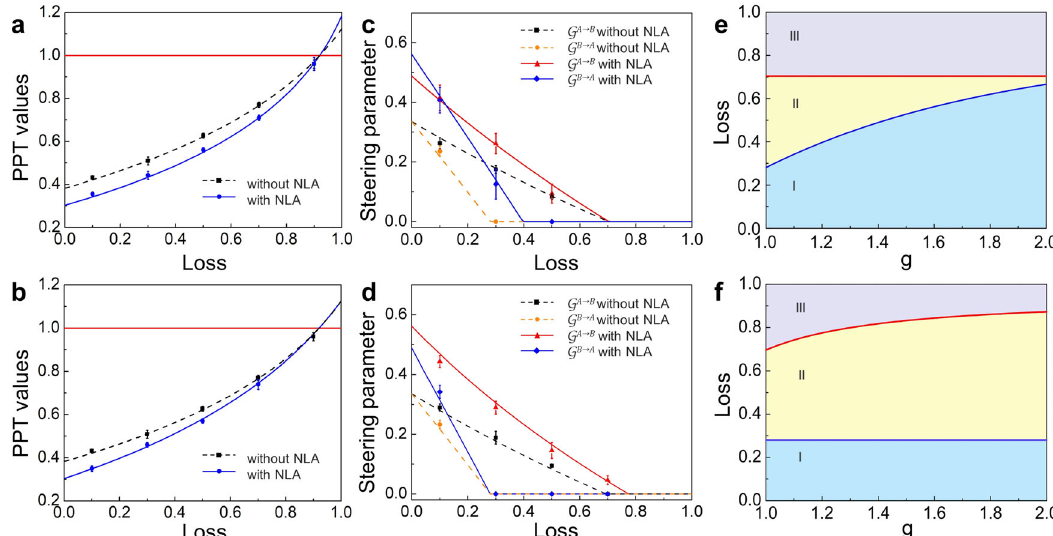
Fig. 3 Results for the distillation in a noisy channel in which the excess noise is taken as 0.12 times of vacuum noise. The PPT values with and without the NLA based on Bob ’ s a and Alice ’ s b measurement results, respectively. Gaussian EPR steering with and without the NLA based on Bob ’ s c and Alice ’ s d measurement results, respectively. The EPR-steerable regions parameterized by loss and gain with the NLA based on Bob ’ s e and Alice ’ s f measurement results, respectively. The blue, yellow, and gray regions are the two-way steerable region (I), one-way steerable region (II), and nonsteerable region (III), respectively. Error bars correspond to one standard deviation from statistical